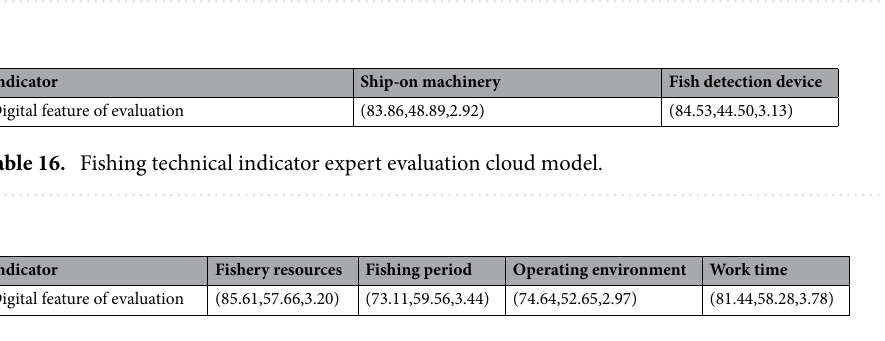
Table 17. Resources and distribution indicators of fishing objects Evaluation cloud model.